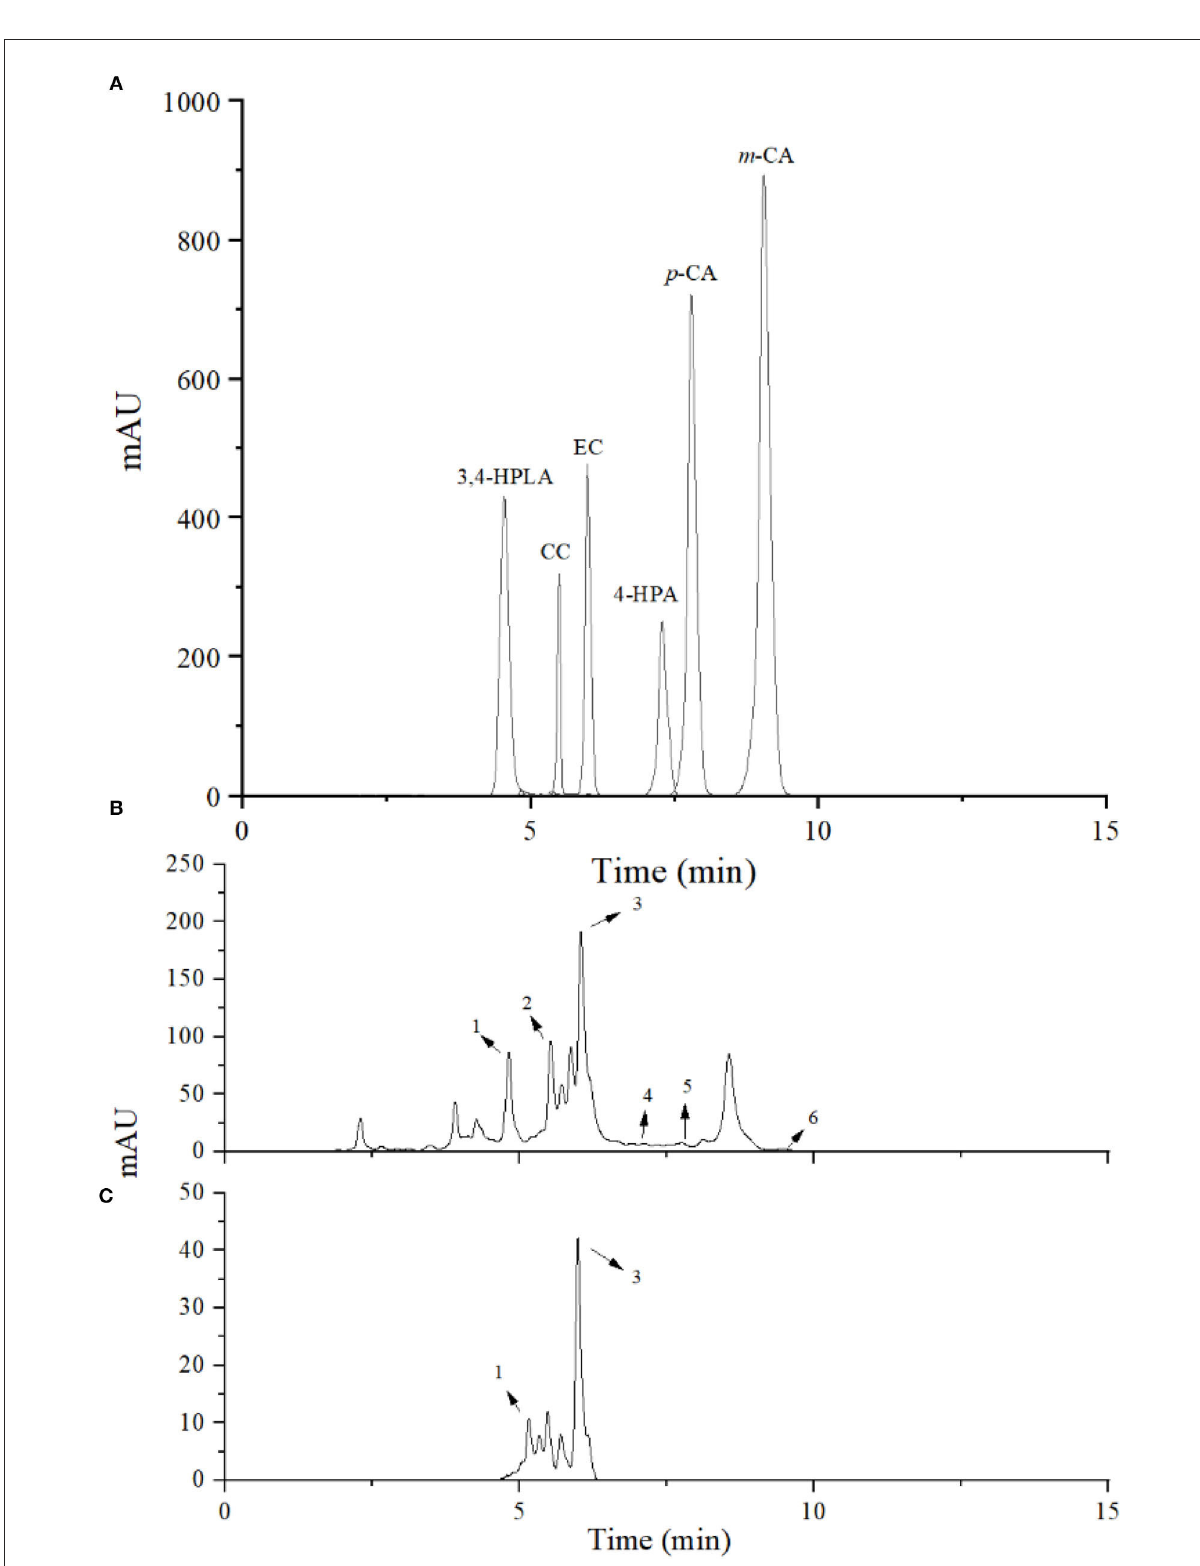
FIGURE3 High-performance liquid chromatography (HPLC) chromatogram of bioconversion products. Standard phenolic acids (A) , litchi pericarp oligomeric procyanidins (LPOPCs) after incubation with L. plantarum (B) , and LPOPCs (C) . Peaks 1–6 were 3,4-HPLA, CC, EC, 4-HPA, p -CA, and m